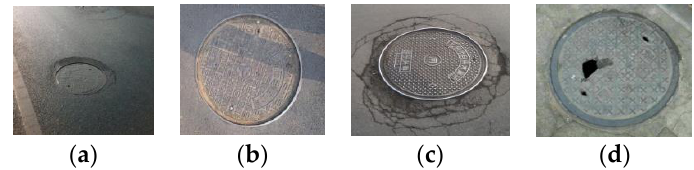
Figure 7. Example manhole cover conditions. ( a ) Sunken manhole rim. ( b ) Sunken manhole cover. ( c ) Damage to the periphery of the manhole. ( d ) Damaged manhole cover.